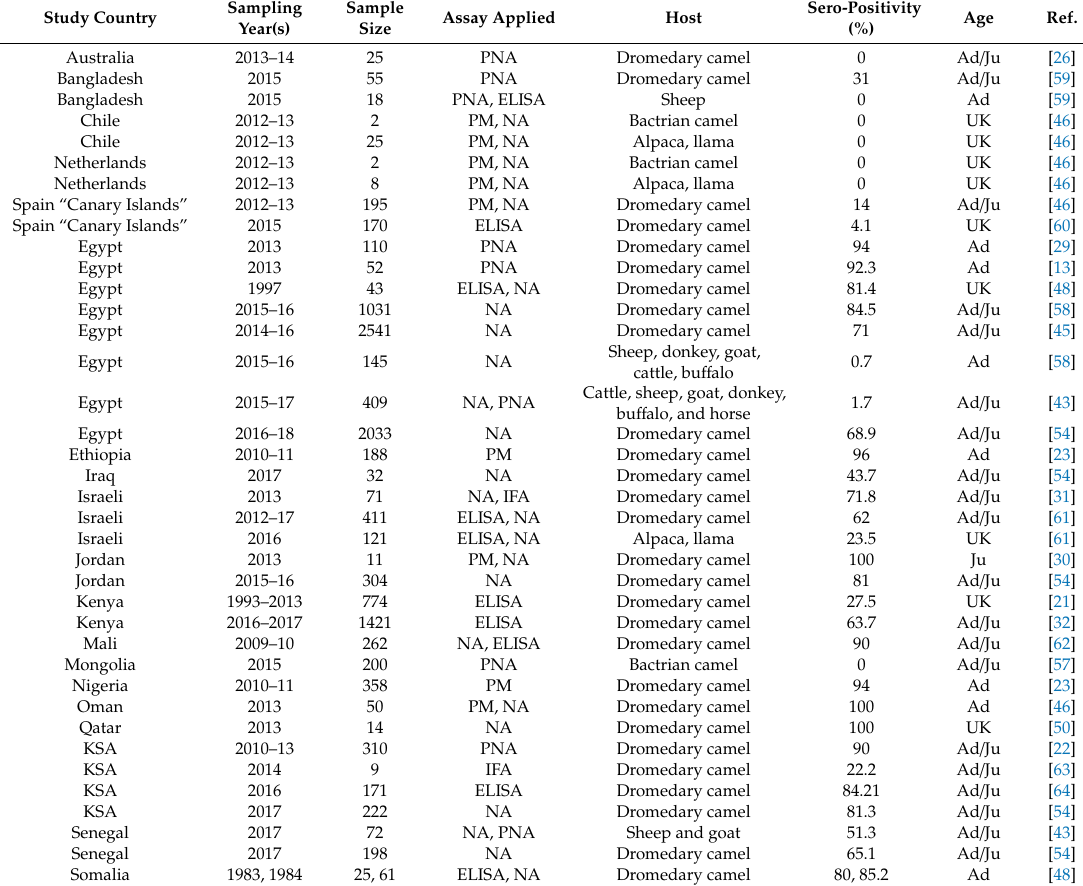
Table 1. Serological evidence of MERS-CoV prevalence in dromedary and domestic animals in the field. Study